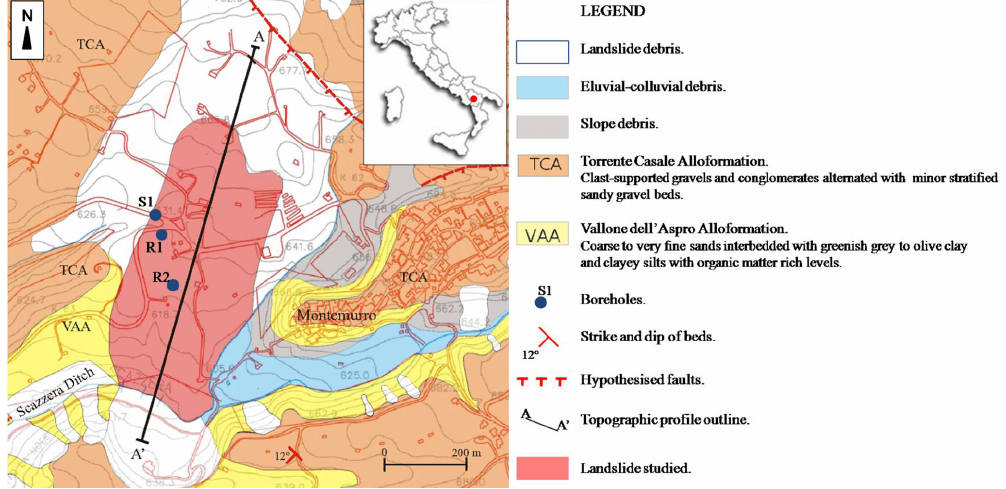
Figure 1. Sketch geological map of the investigated area.